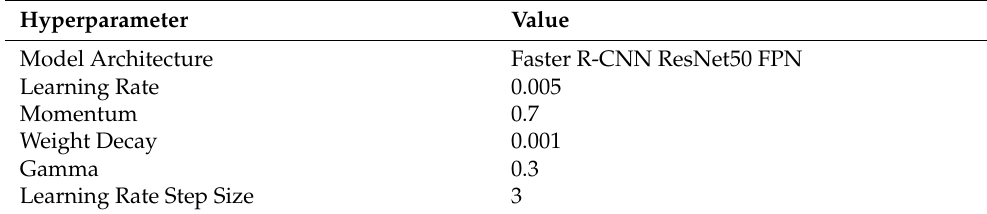
Table 9. Values for the optimized hyperparameters.